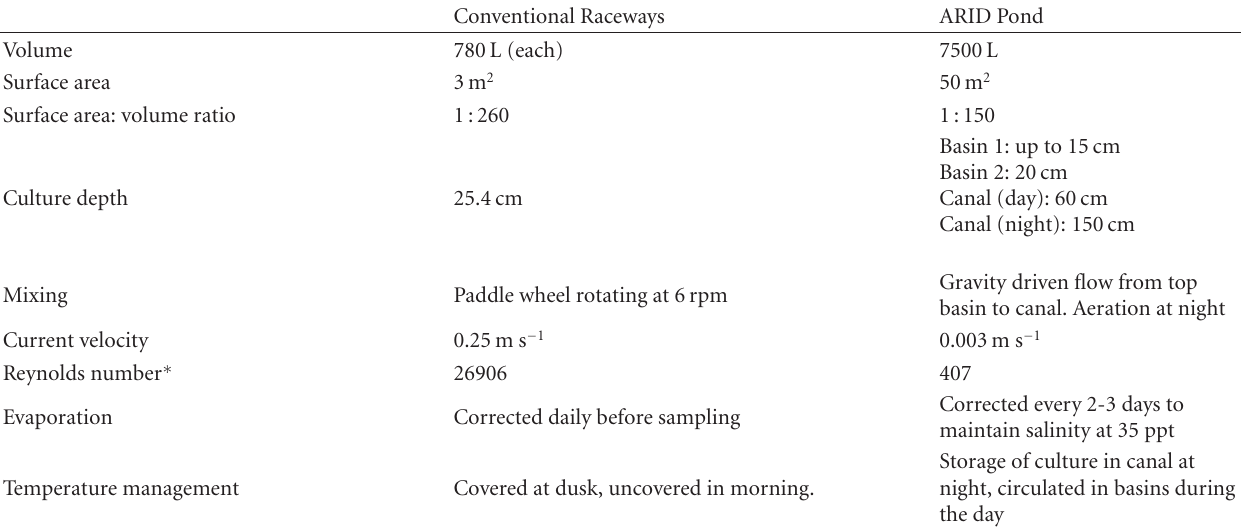
Table 1: ARID pond and conventional raceway